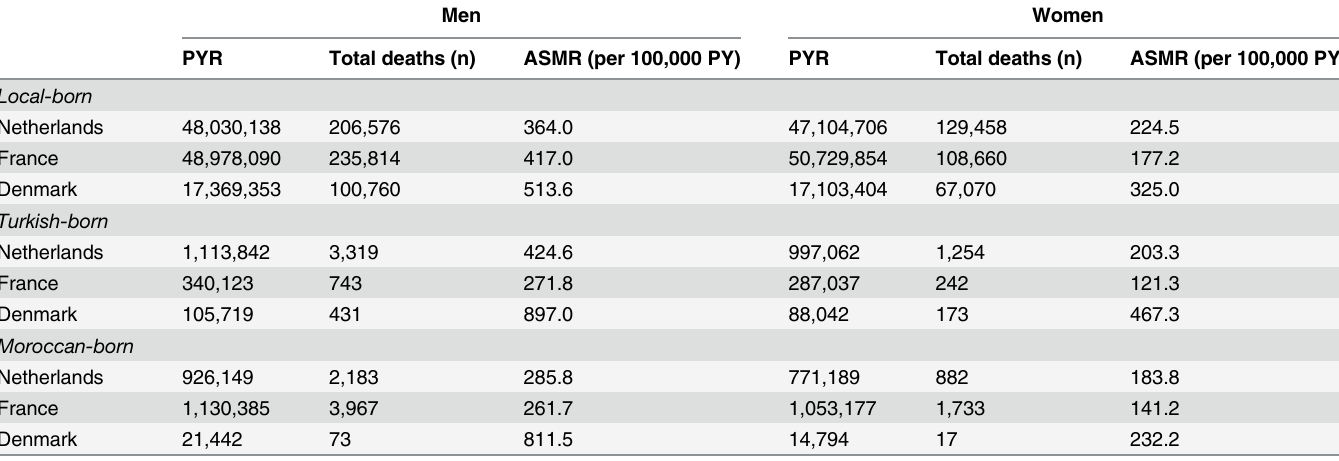
Table 1. Person-years at risk (PYR), total deaths, and age-standardized mortality rate (ASMR) in local-born, Turkish-born and Moroccan-born im- migrants aged 20 – 69 years in three European countries, stratified by